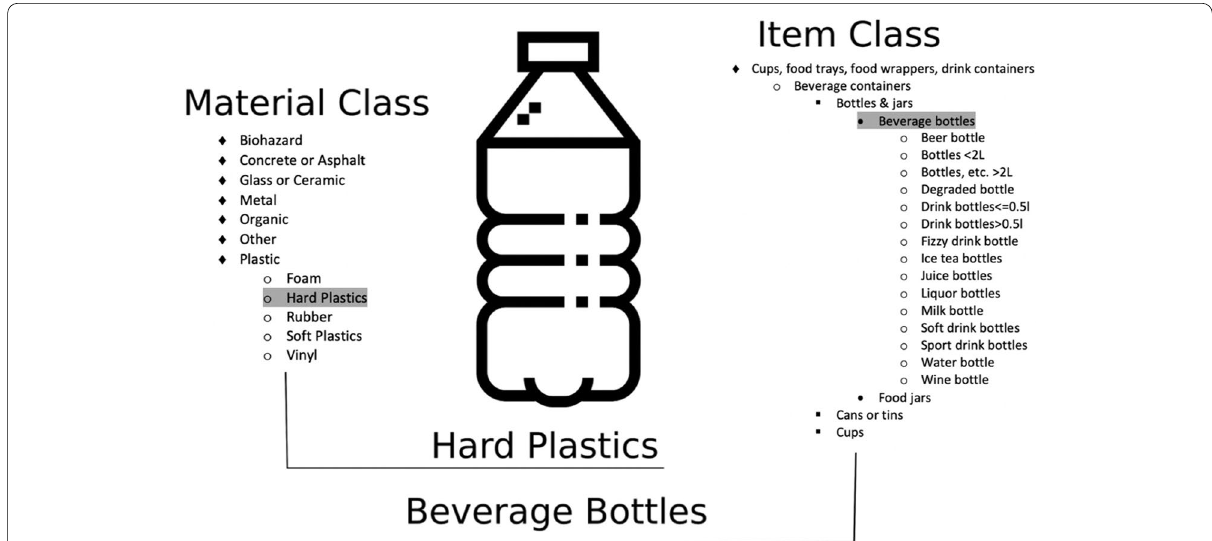
Fig. 1 The object in the center is being classified using the material and item hierarchies on the TTT website. In this example of classifying an unlabeled plastic bottle, we can tell that it is made out of hard plastic and is a beverage bottle. However, we cannot tell what type of beverage bottle it is, so it should be classified generically as a beverage bottle. The classes hard plastic and beverage bottles are chosen to best represent the object in as much detail as possible, without assuming beyond the specificity we can